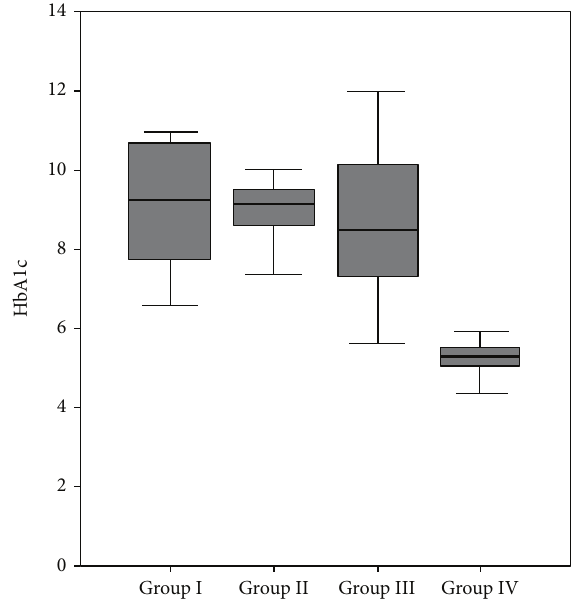
Figure 1: Distribution of HbA1c within the groups.